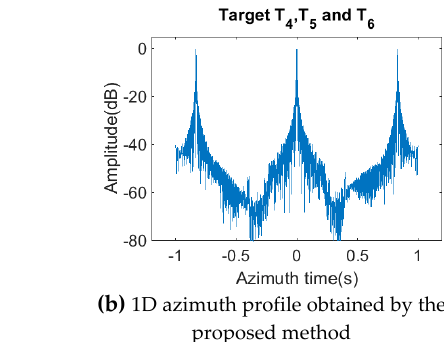
Figure 15. 1D Azimuth profiles of T 4 , T 5 , and T 6 : ( a ) 1D azimuth profile obtained by the adding zeros operation; and ( b ) 1D azimuth profile obtained by the proposed method.